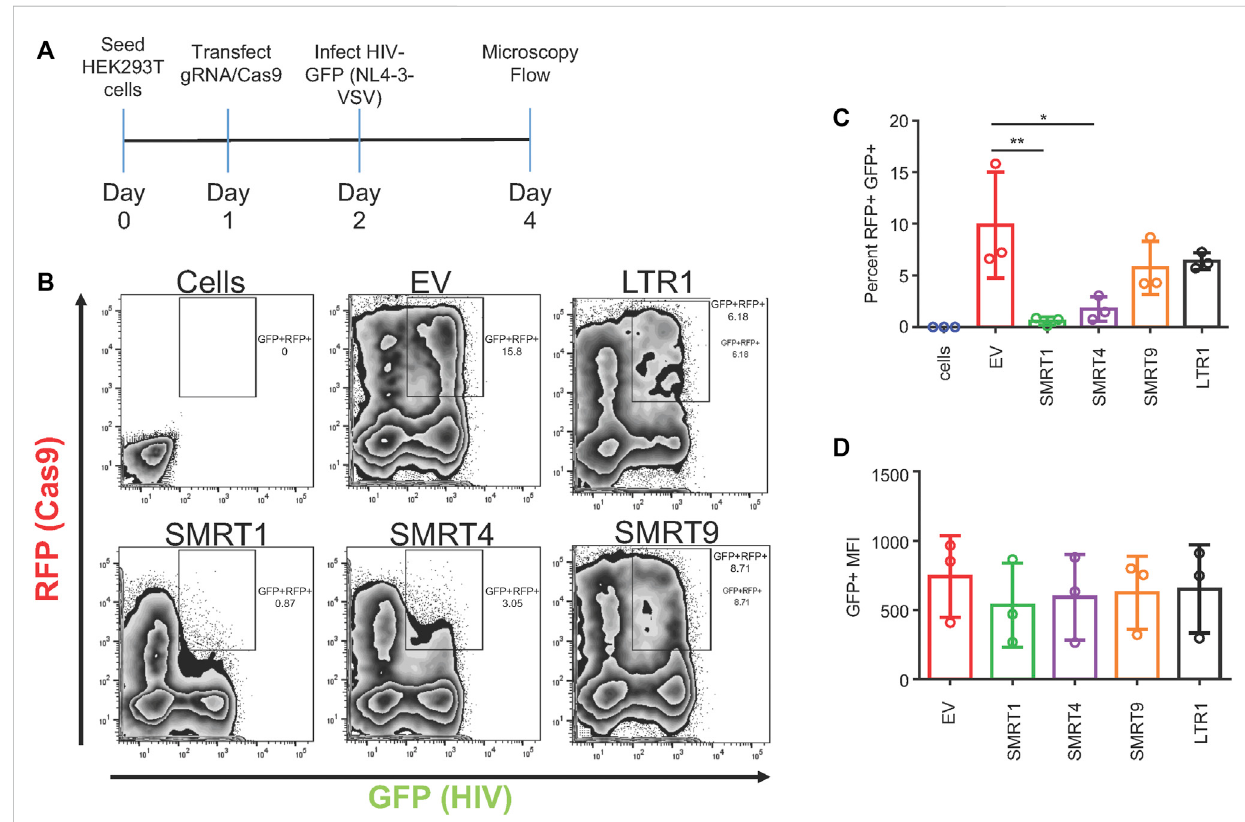
FIGURE 5 gRNAs targeting TAR were able to suppress HIV-1 GFP expression in a pseudotype infection. HEK-293T cells were transfected with the all in one Cas9 plasmid. Twenty four hours post transfection, cells were infected at an MOI of 0.3 with VSV-G pseudotyped HIV-1 GFP. Forty eight hours post- infection, cells were processed for fl ow cytometry. (A) A schematic representation of the experimental timeline. (B) Representative FACS plots showing gatingfordouble-positivecells. (C) Quantitativerepresentationofdouble-positivecells. (D) Mean fl uorescentintensityofGFPfromdouble-positive cells. Error bars represent ± SD. Statistical signi fi cance was determined by using a One-way ANOVA with multiple comparisons. p = * < .05, ** < .01. Data was collected from three independent